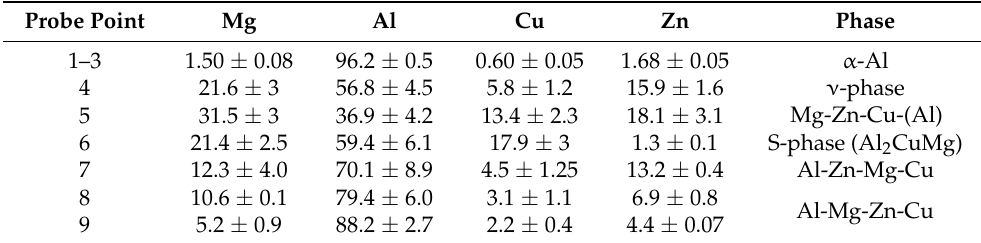
Figure 8. TEM image of a compound ν -phase/S-phase particle in the AA4047/AA7075 transition zone. Table 3. EDS of the compound particle in Figure